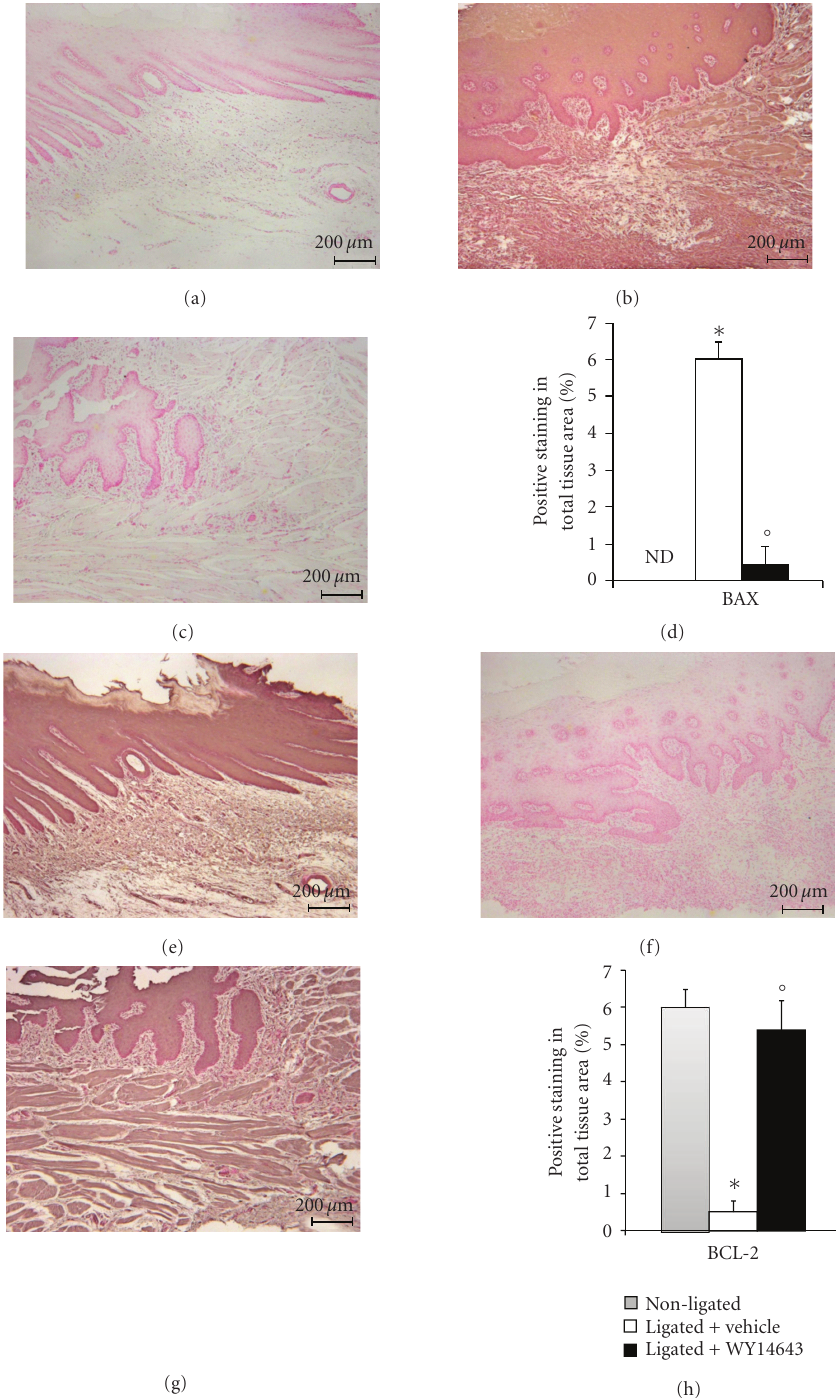
Figure 7: E ff ects of WY14643 on Bax and Bcl-2 expression. No positive staining for Bax was observed in gingivomucosal tissues from the contra lateral side obtained from vehicle-treated rats. (a) Immunohistochemistry for Bax showed positive staining in the gingivomucosal sections after ligature. (b) The degree of positive staining for Bax was markedly reduced in WY14643 treated rats. (c) In immunohistochemical assay the degree of positive staining for Bcl-2 was markedly reduced in gingivomucosal sections obtained after ligature. (f) The reduction of Bcl-2 expression caused by ligature was significantly attenuated in gingivomucosal sections from WY14643treated rats. (g) A normal basal staining for Bcl-2 was observed in gingivomucosal tissues from the contra lateral side obtained from vehicle-treated rats. (e) Densitometry analysis of immunocytochemistry photographs ((d, h); n = 5 photos from each samples collected from all rats in each experimental group) for Bax and Bcl-2 from gingivomucosal tissue was assessed. The assay was carried out by using Optilab Graftek software on a Macintosh personal computer (CPU G3-266). Densitometry data are expressed as % of total tissue area. Figure is representative of at least 3 experiments performed on di ff erent experimental days. ∗ P < . 01 versus nonligated. ◦ P < . 01 versus